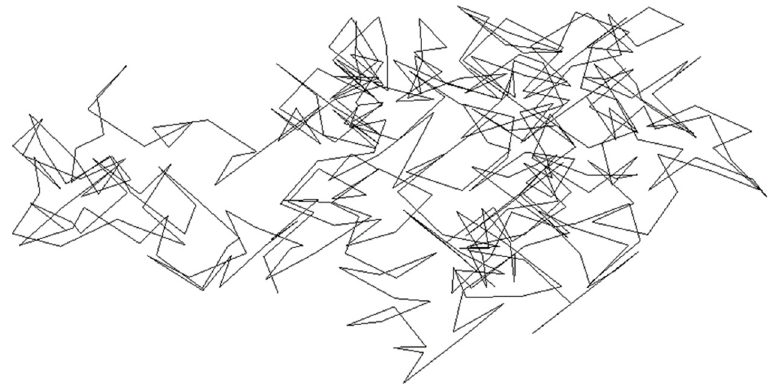
Figure 4. The trajectory of the particle in a two-dimensional chaotic model for the value of parameter, p = 0.9.